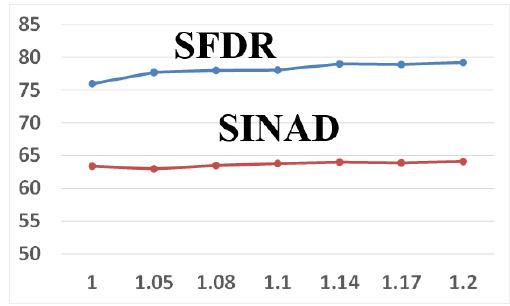
Figure 14. Performances under different supplies.